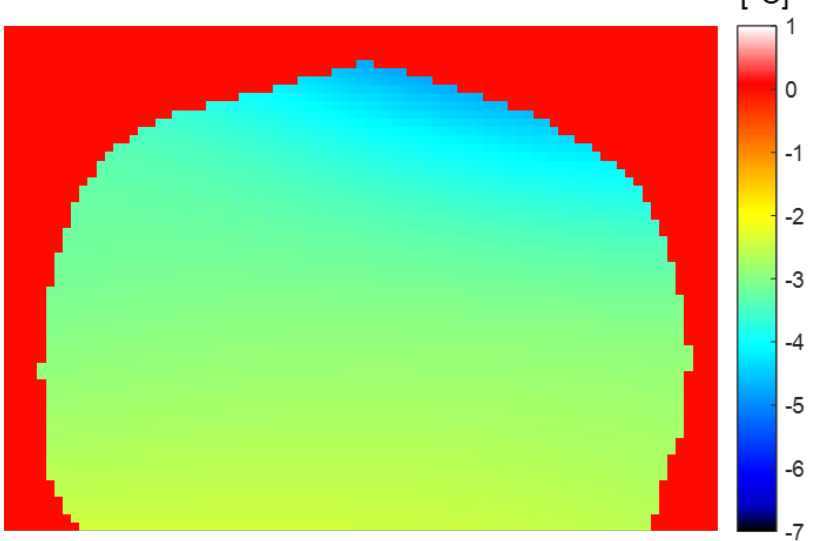
Figure 5. Phase drift map for Figure 3B,C, which is interpolated from the five-point phase measure- ments using the cylindrical oil phantoms around the canine.